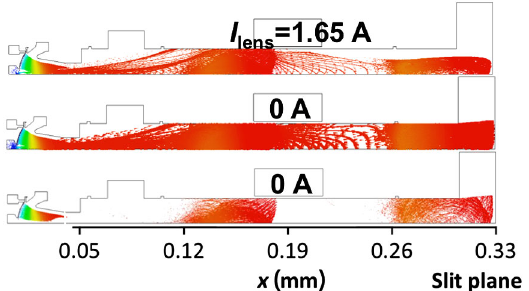
FIG. 11. Simulation of the emission measurements at ¼ (cid:2) 32 kV and effect of the emission from the central V cathode hole. Electron trajectories for: (top) I ¼ 0 A include emission from the central hole; (bottom) I lens ¼ 0 A is with emission from the central hole suppressed. I lens